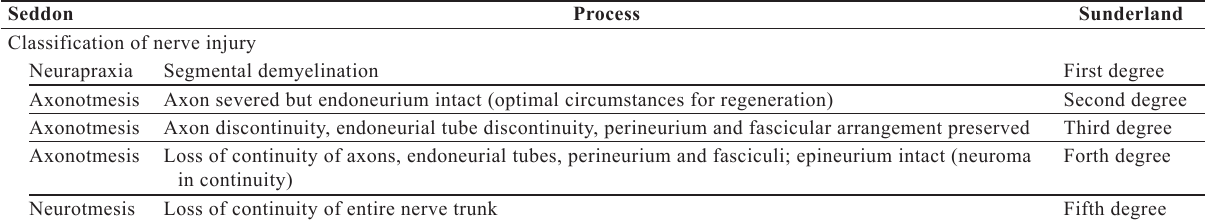
Table 2. The Seddon and Sunderland classifications of nerve